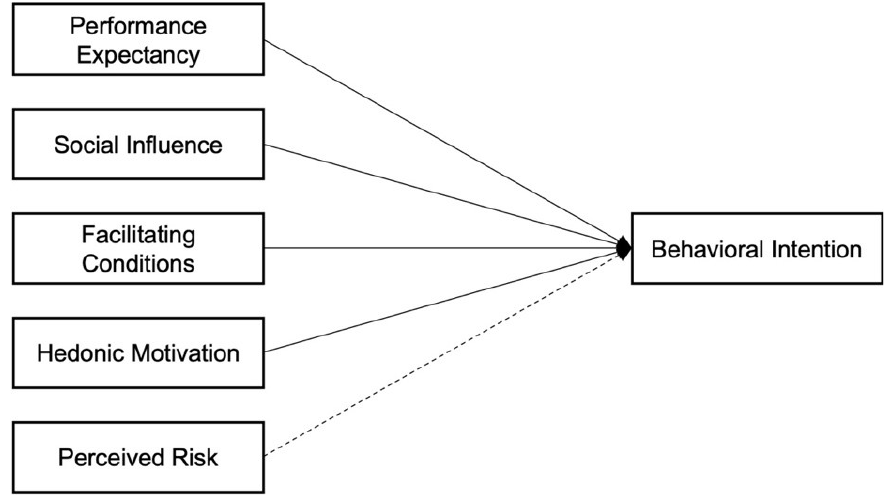
Figure 1. Adapted UTAUT-2.